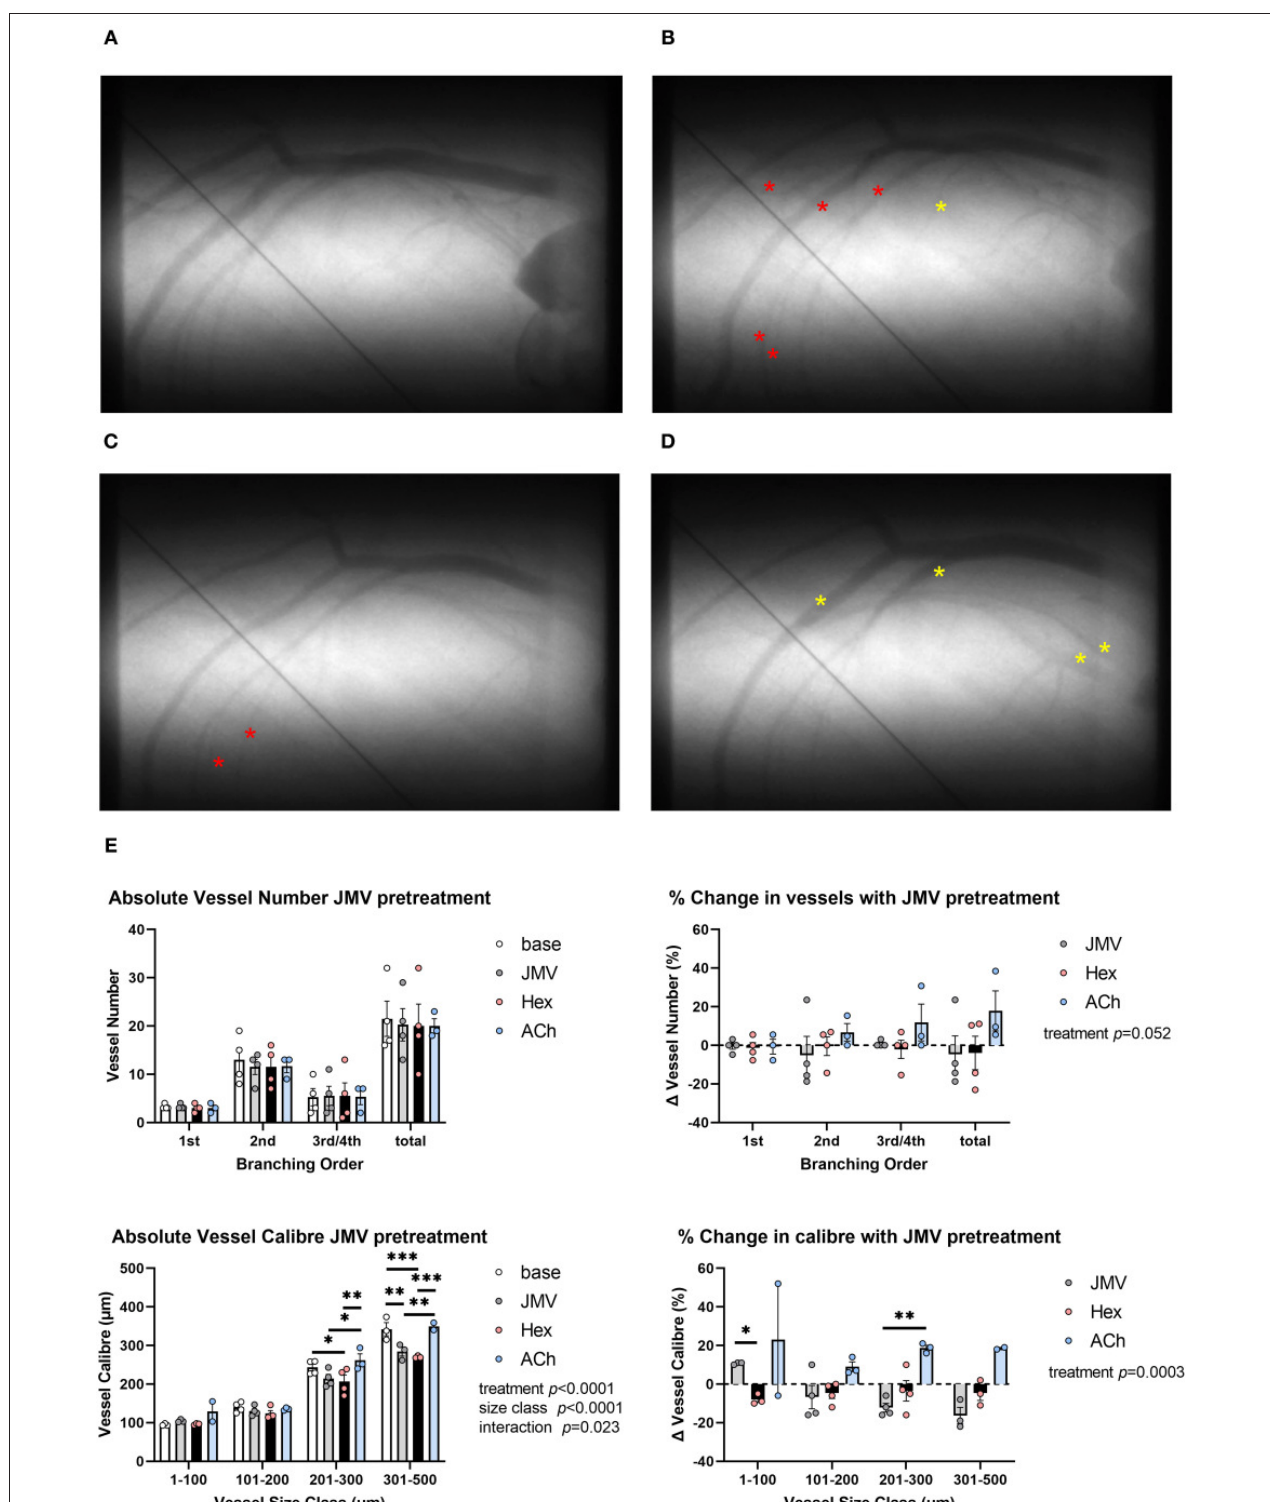
FIGURE 3 | Representative examples of microangiograms acquired from a normal Sprague-Dawley rat during repeated imaging after hex administration following blockade of GHS-R1a with JMV2959 (JMV). (A) Baseline image. (B) Ten minutes after JMV2959 administration (5 mg · kg − 1 i.v.). (C) Ten minutes after blockade